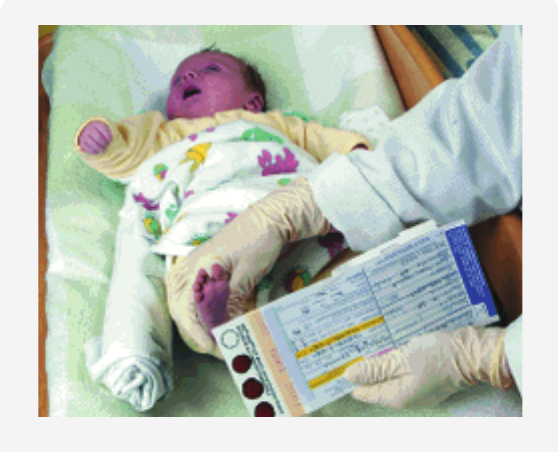
Figure 4. The Guthrie neonatal screening test has been applied to almost every birth in the United States since